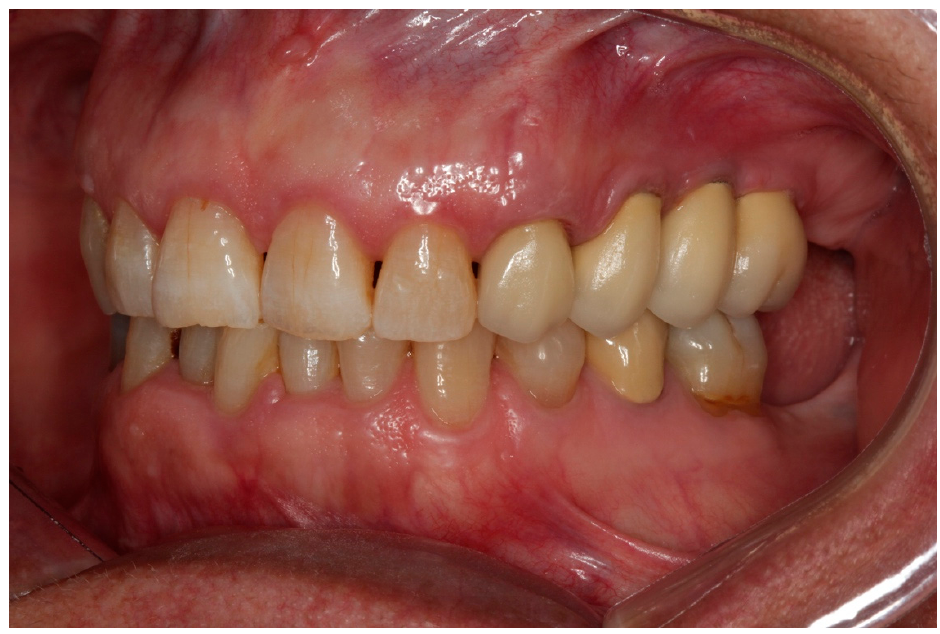
Figure 7. Lateral view of implant crowns.